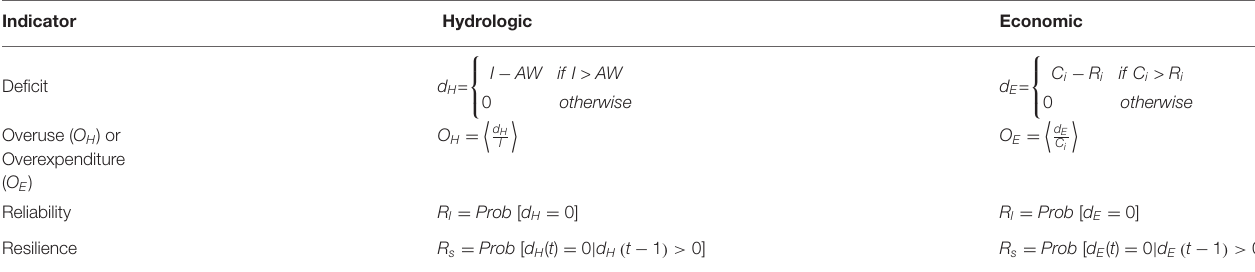
TABLE 1 | Framework for the evaluation of water sustainability.